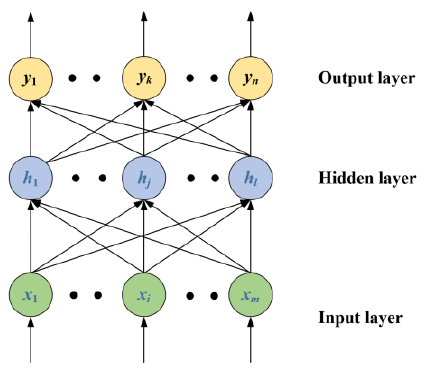
Figure 4. Single hidden layer neural network.